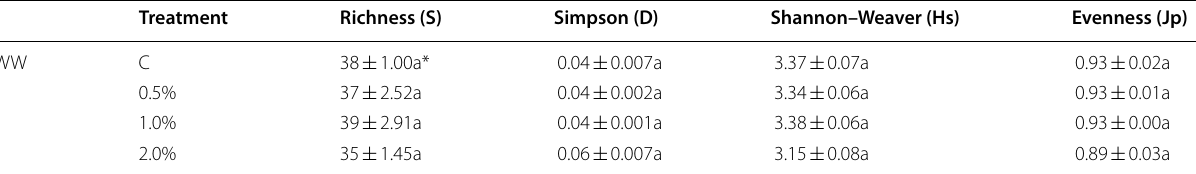
Table 1 Diversity indices calculated from bacterial DGGE profiles associated with pot-grown olive trees fertilized with sheep white wool residues WW, used at 4 different WW/soil percentages